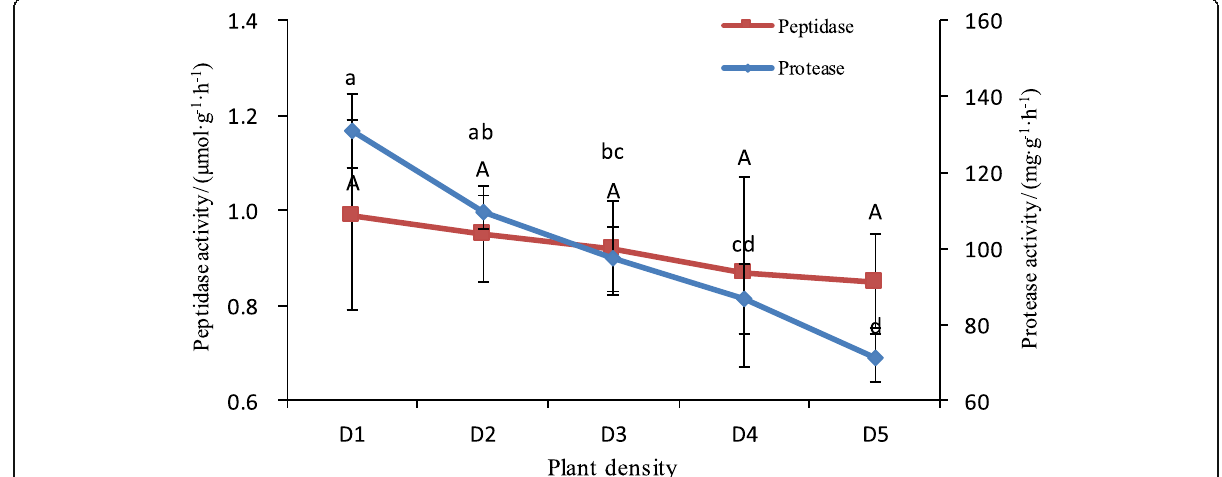
Fig. 5 The protease and peptidase activity in boll wall under different planting densities in 2017. D1-D5: 15 000, 25 000, 45 000, 60 000, and 75 000 plants per hectare. The vertical bar represents S.E. of the mean ( n = 3) when the value exceeds the size of the symbol. Lowercase letters indicate significance analysis among protease activity, and capital letters indicate significance analysis among peptidase activity. The same letter among treatments is not significantly different ( P ≥ 0.05)